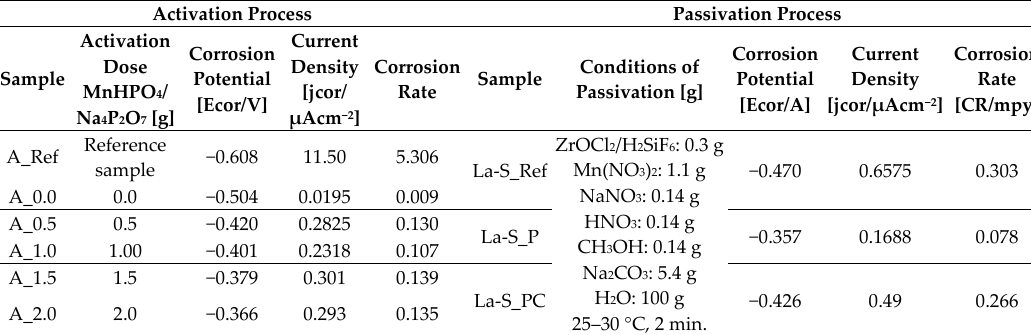
Figure 14. Polarization curves registered for samples subjected to the activation process. To determine the effect of the passivation process on the quality of a phosphate coating two low-alloy steel samples of the same size were prepared, see Figure 15. One sample was prepared with the passivation and oiliness process and another sample was prepared with the passivation process only. In the oiliness process, a solution of mineral oil, emulsifying with water (ZWEZ E-4999) was used. The passivating process of the samples was performed in a bath containing zirconium and silicon